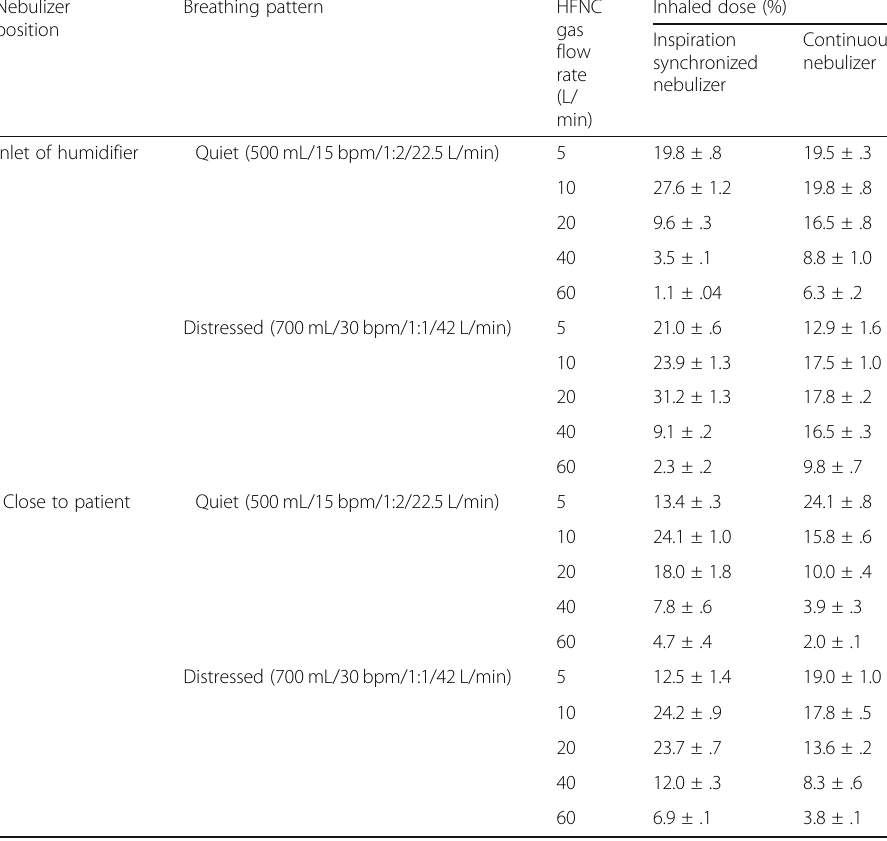
Inhaled dose of inspiration synchronized vs continuous aerosol with the gas flow to patient inspiratory flow ratio